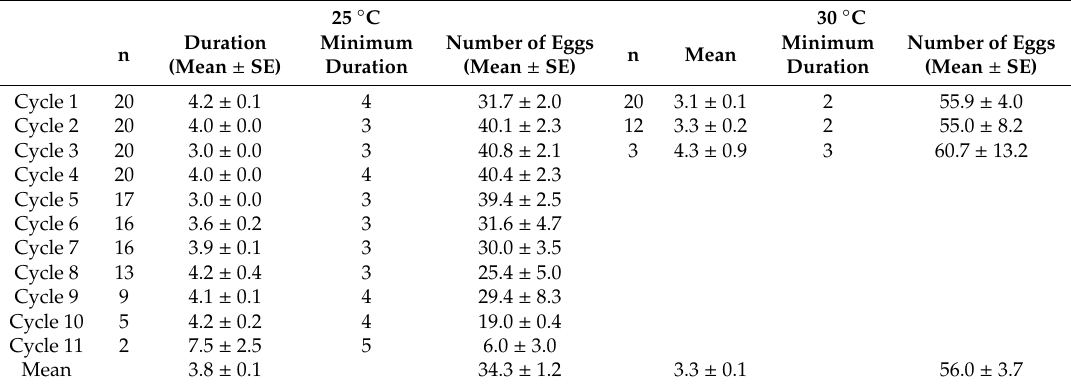
Table 4. Temperate Ae. albopictus fecundity. Duration of gonotrophic cycle (mean and standard error in days) and number of eggs (mean and standard error) for temperate Ae. albopictus at 25 and 30 ◦ C. 25 ◦